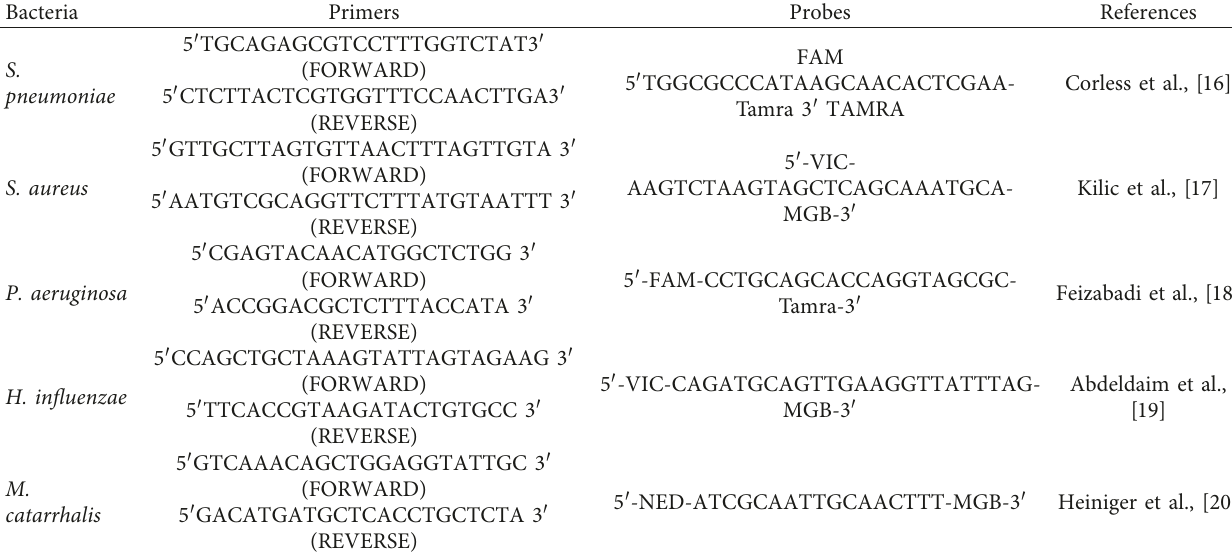
Table 1: Primers and probes used for bacterial detection.